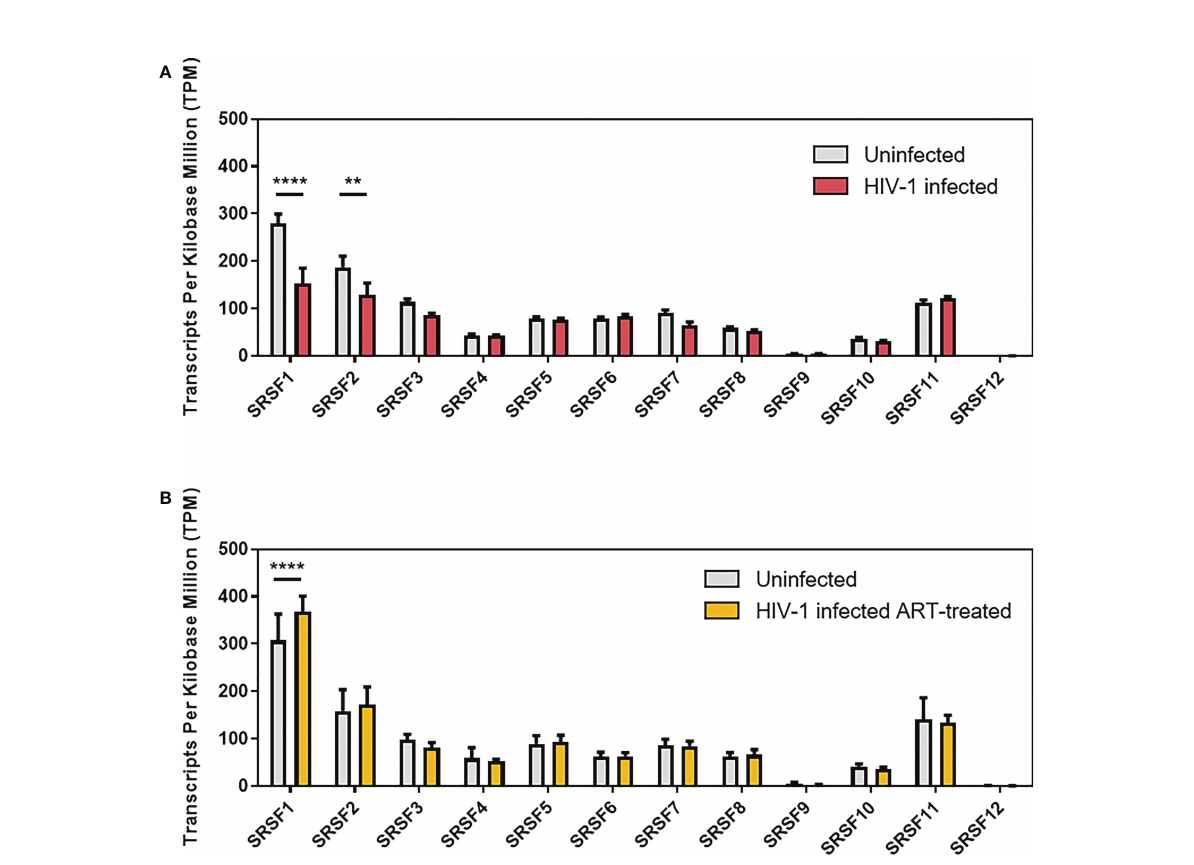
FIGURE 1 Gene expression levels of SRSFs in treatment-naïve or ART-treated HIV-1-infected individuals. Transcript levels of SRSF genes were measured in lamina propria mononuclear cells (LPMCs) from the gut using RNA-sequencing analysis (Supplementary Table 1). Comparison of transcript levels from (A) treatment-naïve HIV-1-infected and healthy individuals and (B) ART-treated HIV-1-infected and healthy individuals. TPM are depicted as mean (+ SD) for (A) 19 HIV-1-infected and 13 uninfected individuals and (B) 14 ART-treated and 11 uninfected individuals. Groups were compared with two-way ANOVA with Bonferroni post-hoc test (** p < 0.01, and **** p <